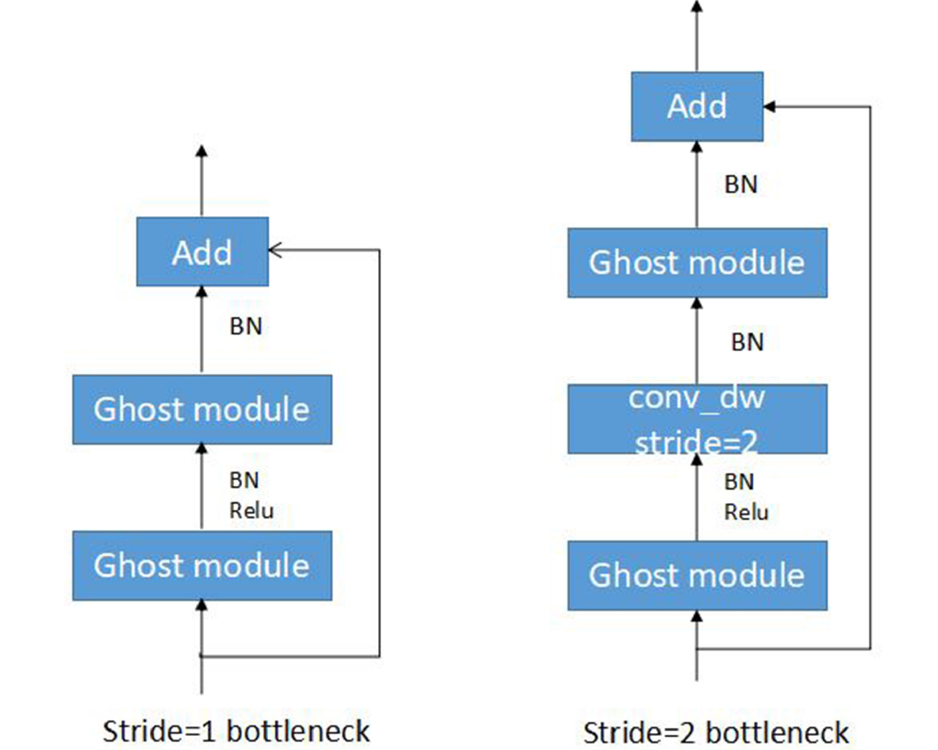
Figure 5. Ghost bottleneck. ( Left ): Ghost bottleneck with stride = 1; ( right ): Ghost bottleneck with stride =